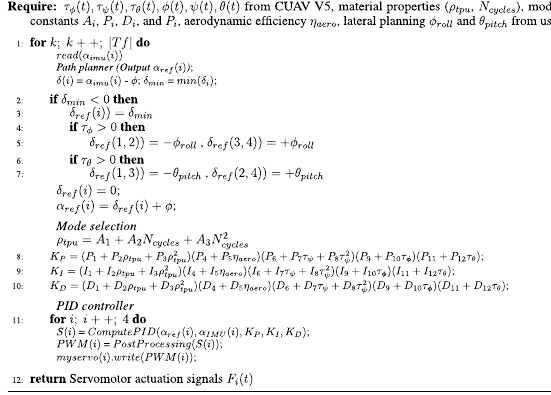
Algorithm 1. Path planner, mode selection and PID controllers for servomotor